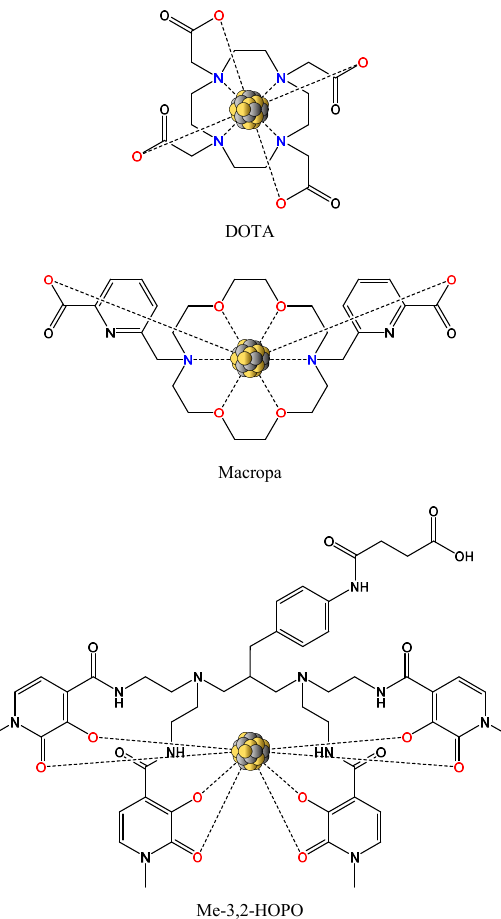
Figure 3. Structure of the current state-of-the-art chelating agent DOTA, next to the structures of the promising chelating agents Macropa for 225 Ac coordination and Me-3,2-HOPO for 227 Th coordination. Each of these chelators offers broad derivatization possibilities to further alter conjugation, labeling efficiency, and complex stability. Coordinating nitrogen donors are highlighted in blue, and oxygen donors in red. DOTA: 1,4,7,10-tetraazacyclododecane-1,4,7,10-tetraacetic acid.